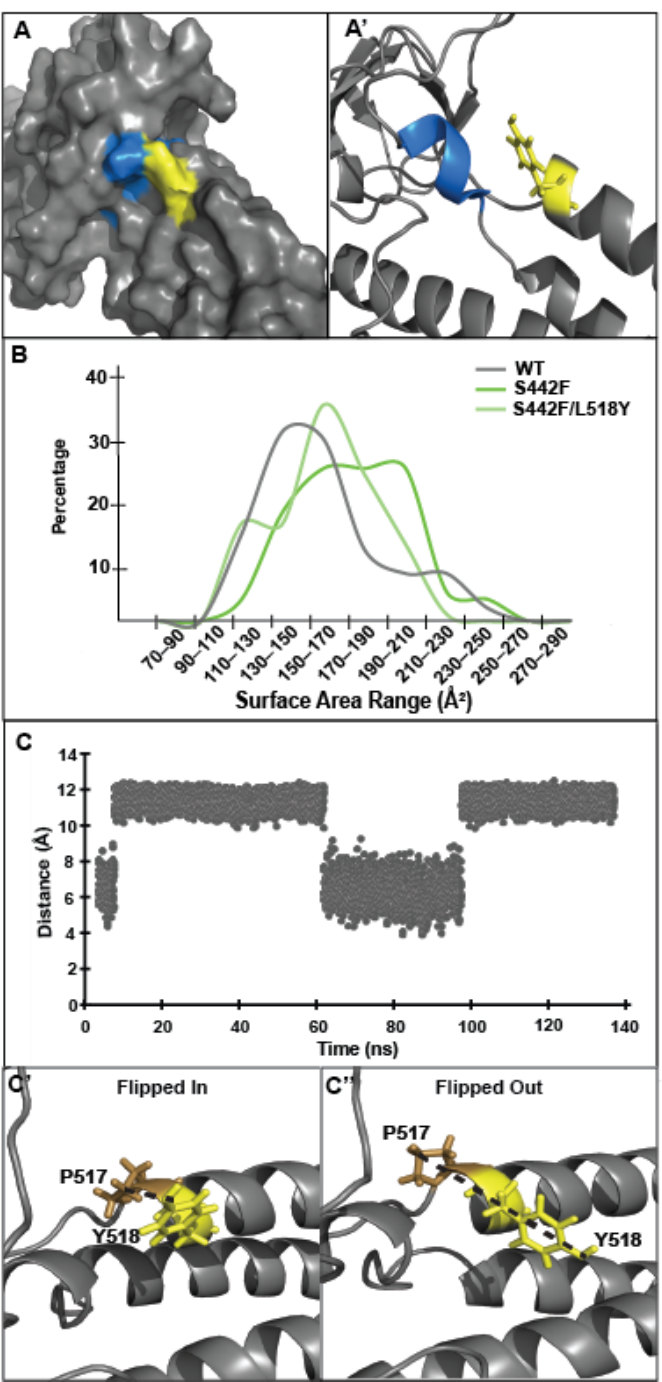
Figure 4. L518Y partially blocks the exposed DSP calpain cleavage site. ( A , A’ ) L518Y covers part of the calpain target site in the ‘flipped in’ position. ( B ) MD simulations of S442F/L518Y show that the inclusion of L518Y decreases the solvent exposure of the calpain target site. ( C , C’ , C’’ ) L518Y in S442F spends roughly 30% of the time in the ‘flipped in’ position, as determined by the distance of L518Y from P517. ‘Flipped in’ is defined as a distance less than 9 Å between the side chains of L518Y and P517.